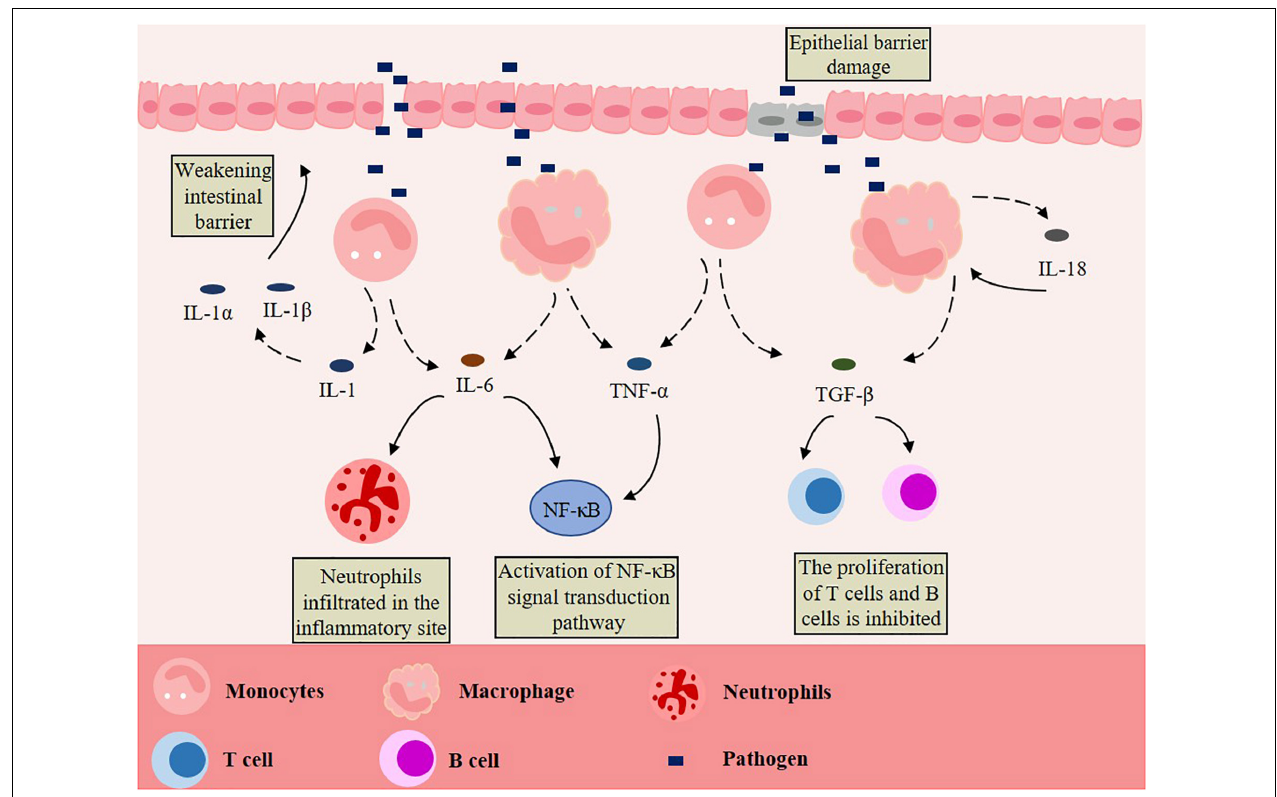
FIGURE 1 | Macrophages promote the development of IBD. Pathogens cross the damaged intestinal epithelial cell barrier and stimulate macrophages to produce pro-inflammatory cytokines, such as interleukin-1 (IL-1), IL-6, IL-18, transforming growth factor- α (TGF- α ) and tumor necrosis factor- β (TNF- β ) are released. These act on intestinal epithelial cells directly or indirectly, leading to the injury or necrosis of these cells, thus promoting the occurrence and development of